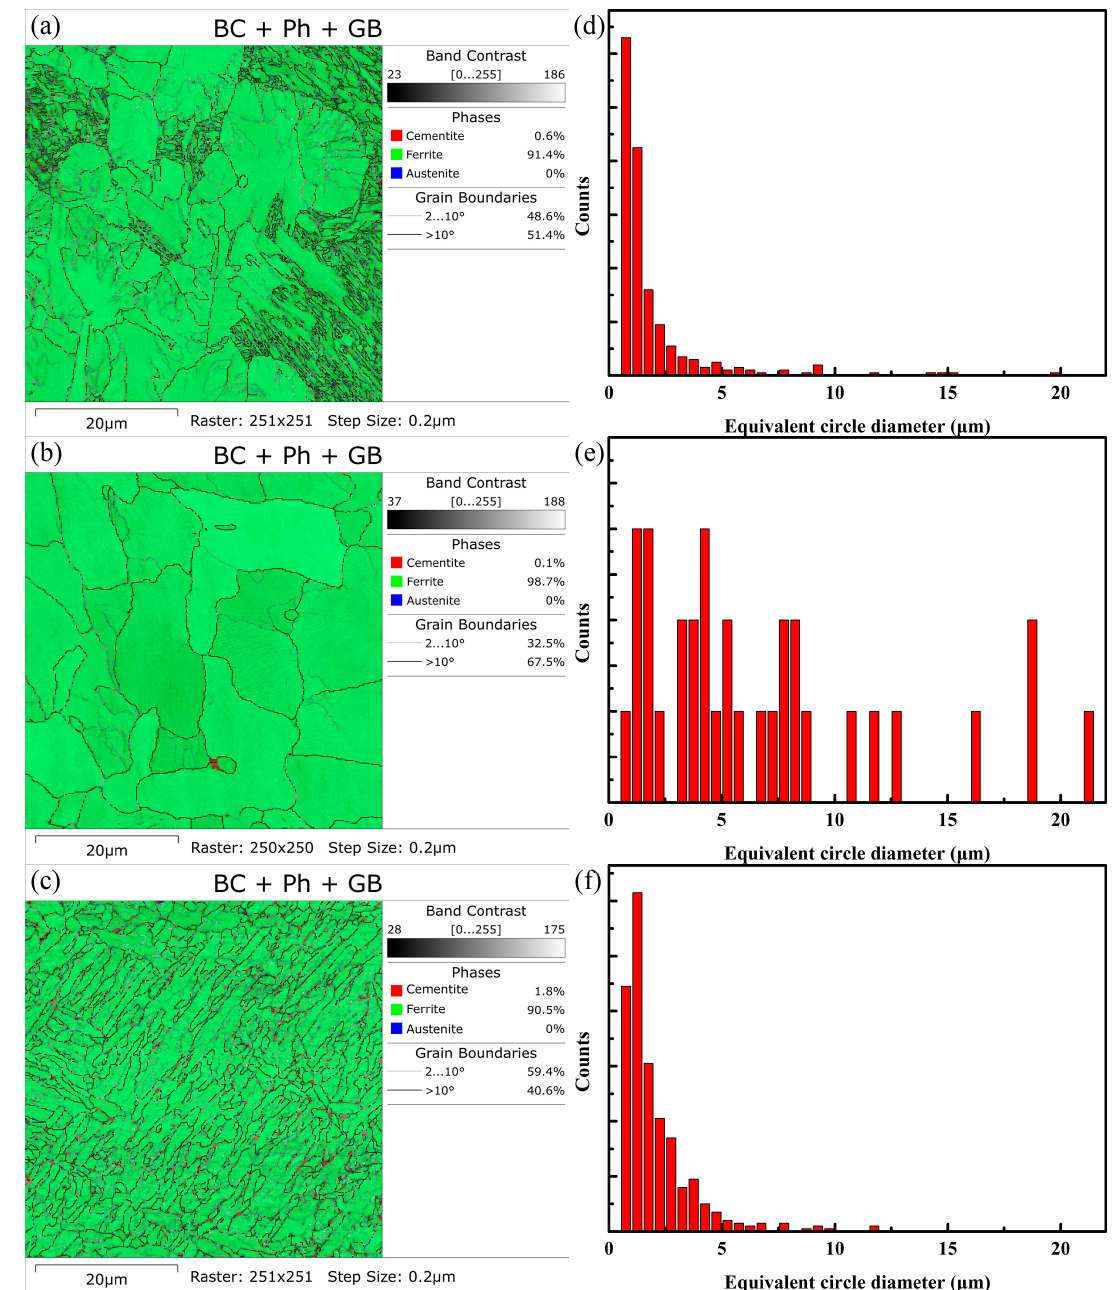
Figure 4. EBSD images (Band Contrast + Phase + Grain Boundary) and corresponding grain size statistics. ( a – c ) are the EBSD images of QT, NT, and ST, respectively. ( d – f ) are the grain size statistics of QT, NT, and ST, respectively.